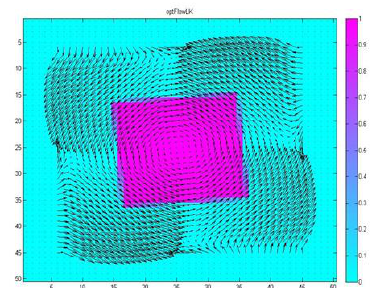
Figure 18. Results of Lucas/Kanade (Win=5, Sigma=1)